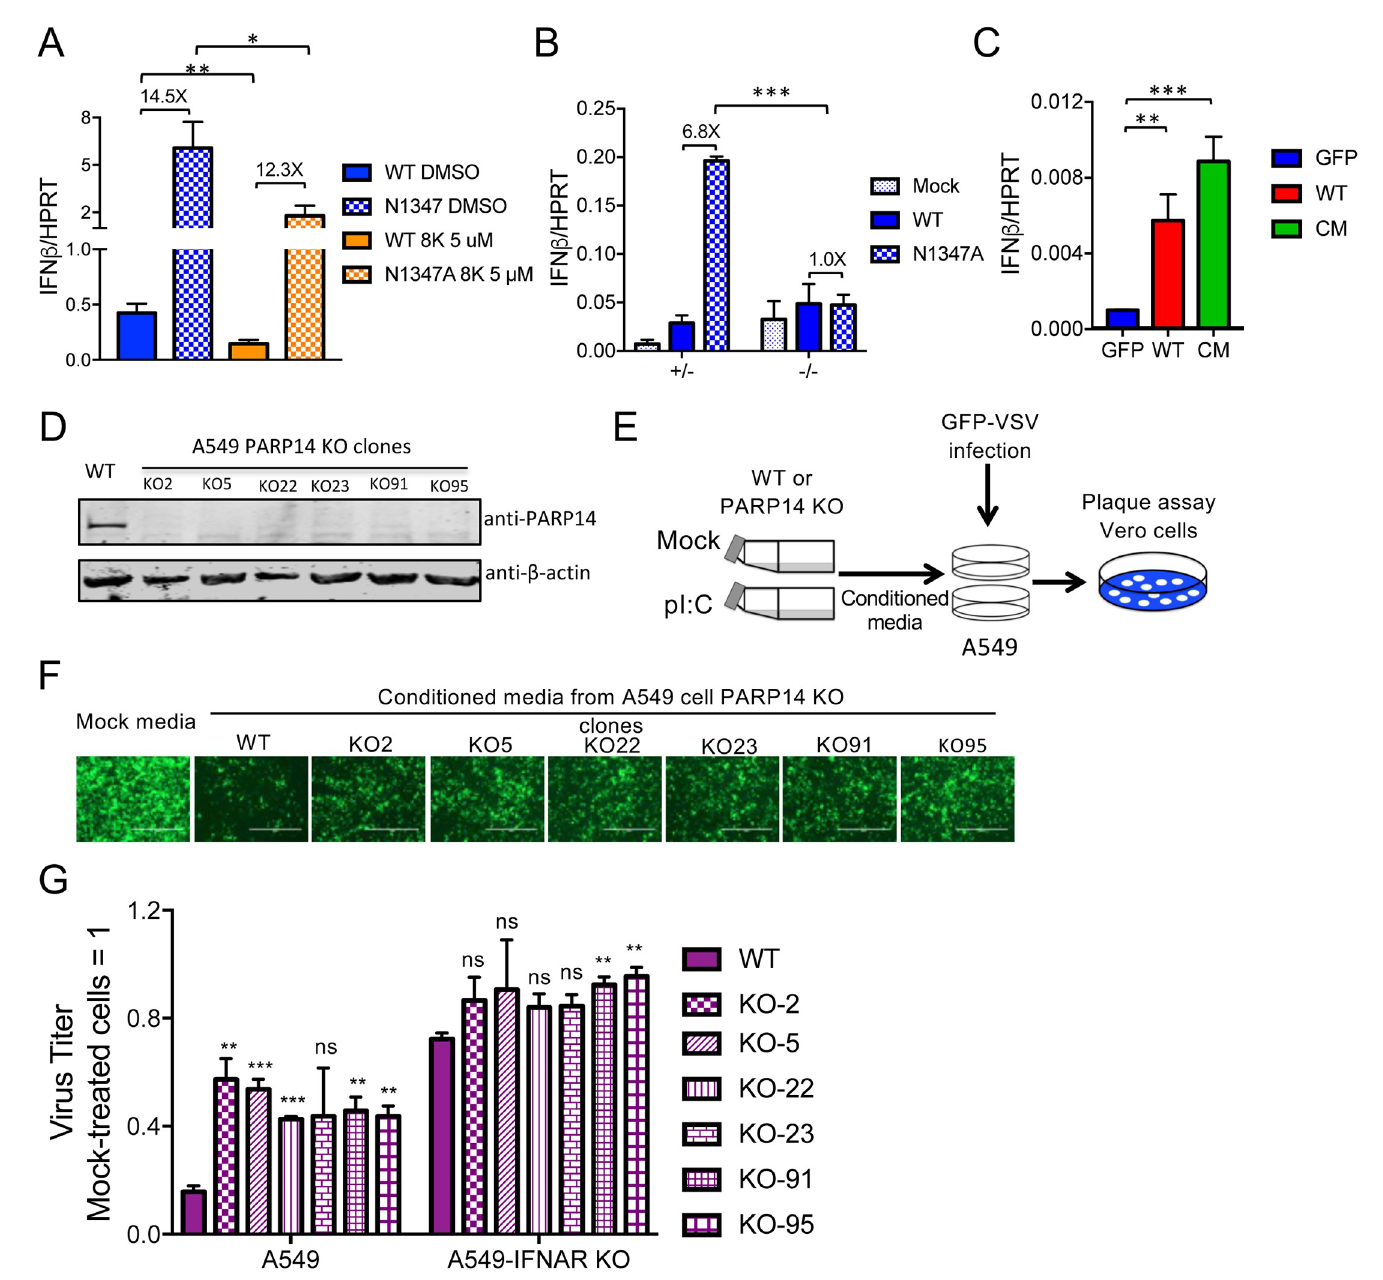
Fig 6. PARP14 is required for an efficient IFN response following infection or poly(I:C) induction. (A) BMDMs were infected with WT or N1347A MHV and treated with 5 μ M compound 8K or vehicle (DMSO) following a 1-hour adsorption phase. Cells were collected at 12 hpi, and IFN β mRNA levels were determined by RT-qPCR. The data in (A) represent the combined results of three experiments; n = 9. (B) PARP14 -/- or PARP14 +/- littermate control BMDMs were infected with WT or N1347A virus. Cells were collected at 12 hpi, and IFN β mRNA levels were determined by RT-qPCR. The data in (B) show one experiment representative of four independent experiments. (C) DBT cells were transfected with plasmid expressing GFP, PARP14, or a PARP14 catalytic mutant (CM). Cells were collected at 24 hours after transfection, and IFN β mRNA levels were determined by RT-qPCR. The data in (C) show one experiment representative of two independent experiments; n = 3. (D) Six clones of CRISPR/Cas9-gRNA-mediated PARP14 KO A549 cells or gRNA-NC-transduced (irrelevant gRNA) control A549 cells were collected and analyzed by immunoblotting for PARP14 protein. (E) Schematic diagram illustrating the antiviral conditioned media assay (see Methods for details). (F,G) At 16 hpi, VSV replication on WT or IFNAR KO A549 cells was analyzed by fluorescence microscopy (F), and titers were determined by plaque assay on Vero cells (G). The images in (F) are of a single experiment representative of three independent experiments. Titers in (G) were normalized to those in cells receiving mock-treated conditioned media. The data in (G) show the combined results of three independent experiments; n = 3. x-axis labels represent VSV-infected cells. p-values represent comparisons of each poly(I:C) (pI: C)-treated PARP14 KO cell conditioned media to poly(I:C)-treated WT cell conditioned media used to pretreat WT or IFNAR KO A549 cells. Numbers above bars represent fold difference between WT and N1347A or between siPARP/siCtl or inhibitor/DMSO-treated cells infected with N1347A virus.